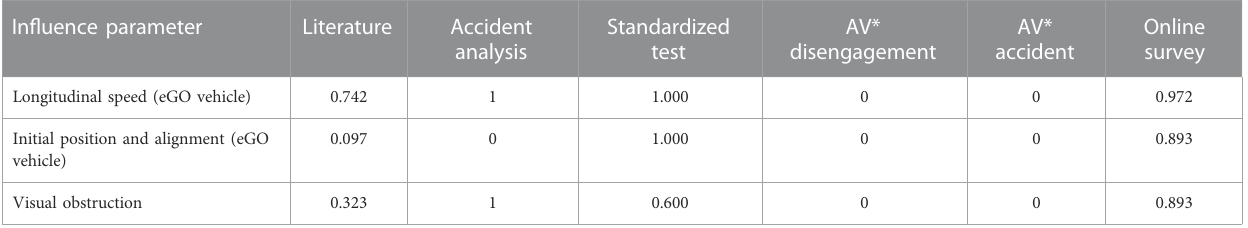
TABLE 5 In fl uence parameters classi fi ed differently by K-prototype and Ward ’ s hierarchical clustering (K-prototype: most important; Ward: less important).